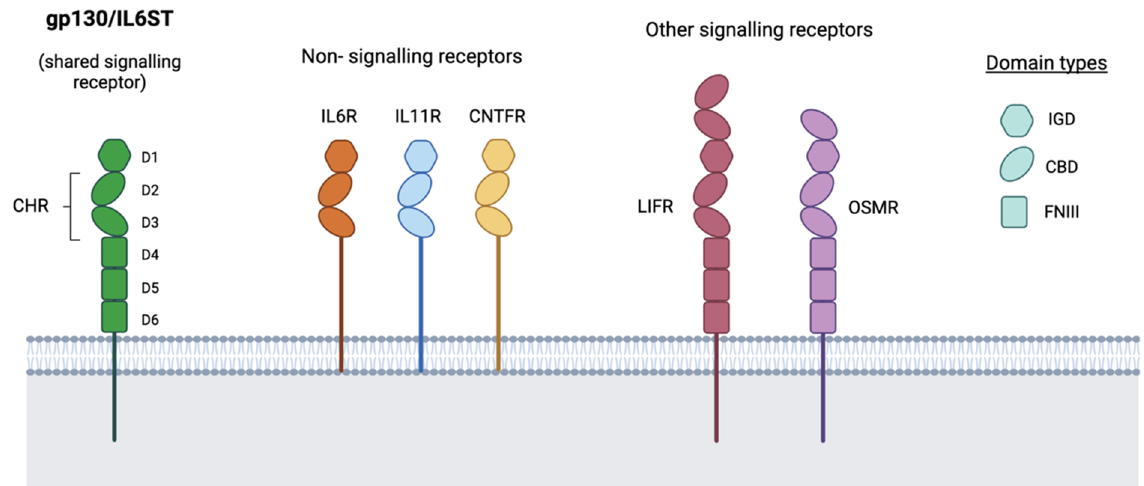
Figure 1. Structure of receptors in the IL6-like family. Receptors for cytokines in the IL6-like family present a modular structure with conserved motifs. Both signalling and non-signalling receptors include a single immunoglobin-like domain (IGD) and a cytokine-homology region (CHR), made up of cytokine-binding domains (CBD). Signalling receptors also present a membrane-proximal element including several copies of a fibronectin type III-like (FNIII) domain. The ectodomain of the shared signal transducer gp130/IL6ST consists of 6 domains, with the 3 membrane-distal ones (D1-D3) being essential for binding to the cytokine (and the non-signalling receptor, where this is required). Other signalling receptors, such as LIFR and OSMR, present larger ectodomains consisting of variations of this modular structures. Table 1. Members of the IL6-like cytokine family and their respective receptors.